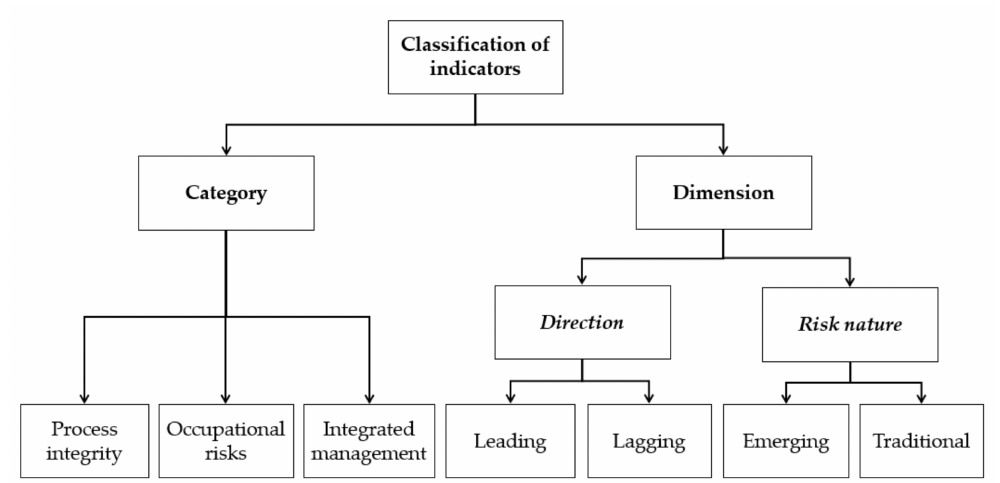
Figure 3. Classification of indicators (Own elaboration).